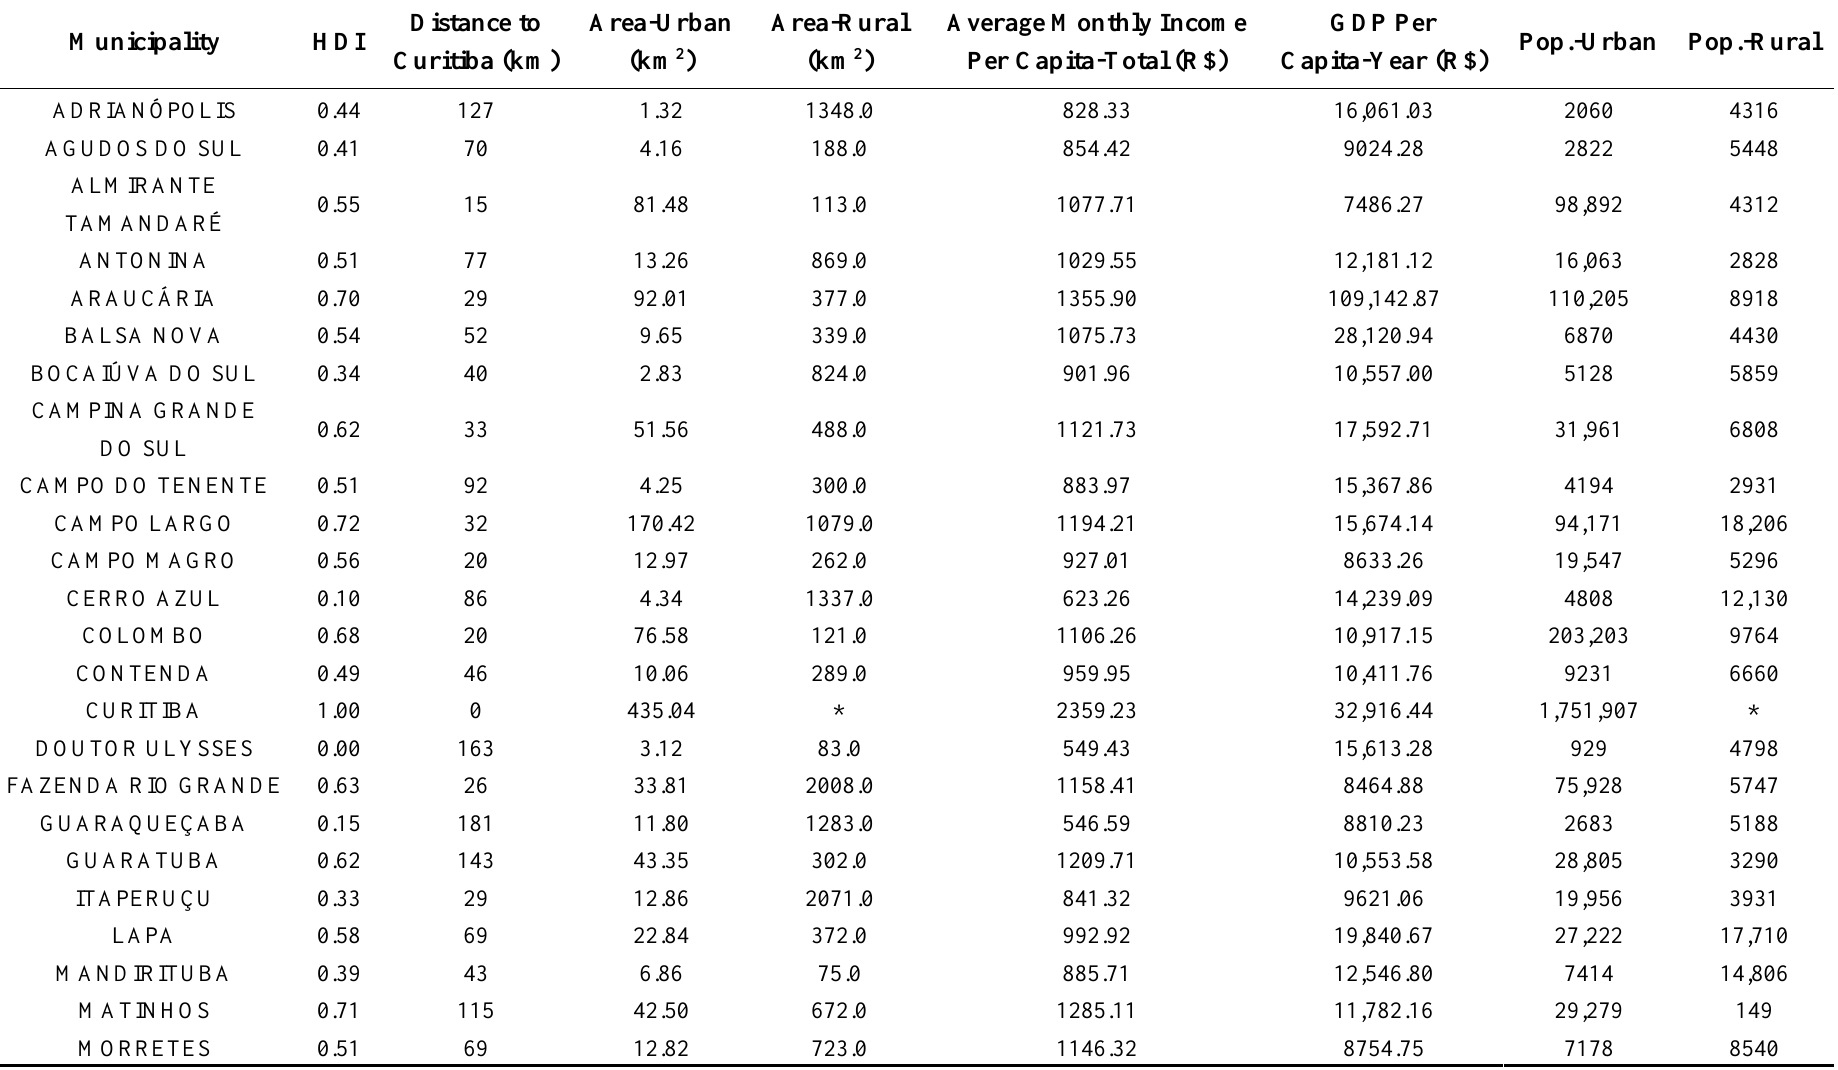
Table 1. The selected municipalities comprising the Metropolitan Mesoregion of